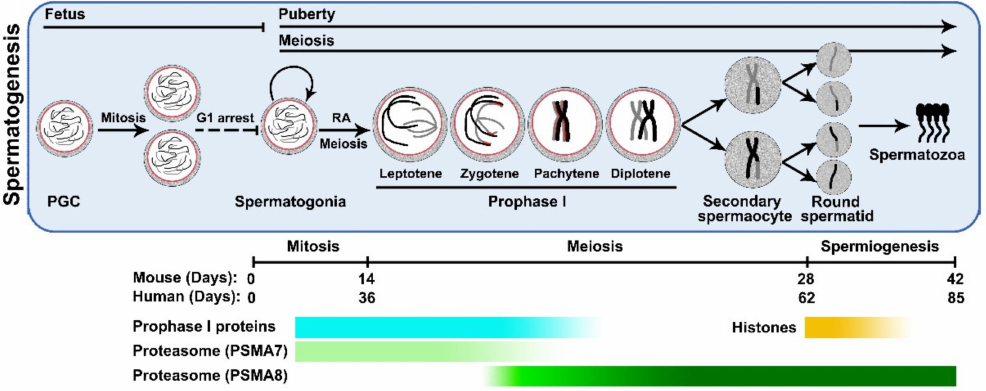
Figure 1. The processes of mammalian spermatogenesis. In males, primordial germ cells (PGCs) are specialized at early stages of fetal development and are arrested at G1 phase. After birth, PGCs differentiate to give rise to spermatogonia in male gonads, or testis. Spermatogonia undergo several rounds of mitosis to produce Asingle (As), Apaired (Apr), Aaligned (Aal), A1–4, intermediate and B types of spermatogonia, progressively. Type B spermatogonia are able to enter meiosis in response to the retinoic acid (RA) signalling. Through homologous recombination and synapsis at Prophase I, homologous chromosome segregation at Metaphase I and sister chromatids separation at Metaphase II, one spermatocyte divides to form 4 haploid round spermatids with ploidy reduction. Following the process of spermiogenesis, round spermatids mature to become spermatozoa with the capacity to fertilize MII eggs. The timelines of spermatogenesis in mouse and human are indicated (not to scale). The degradation timing of regulatory proteins involved in meiotic prophase I (Prophase I proteins) and histones as substrates of UPS, as well as the expression pattern of 20S proteasome subunits PSMA7 and PSMA8 are labeled with Gradient